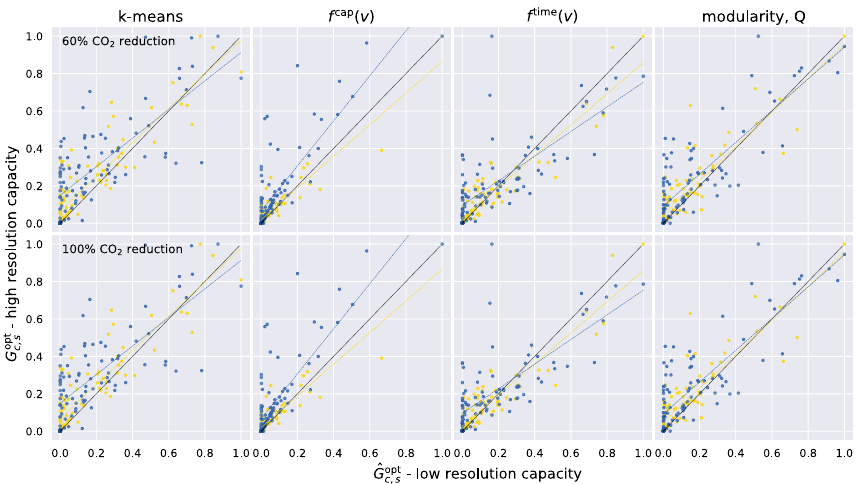
Fig. 10 Normalised mapping of optimal capacities according to equation (12): The x-axis reflects the estimated optimal capacity of a the low resolution model ˆ G c , s , while the y-axis displays the totalised optimal capacities of the high-resolution model. The two considered technologies wind and solar are outlined using different colors. A linear fit to the respective data is added to the plots. A black line depicts a theoretical perfect